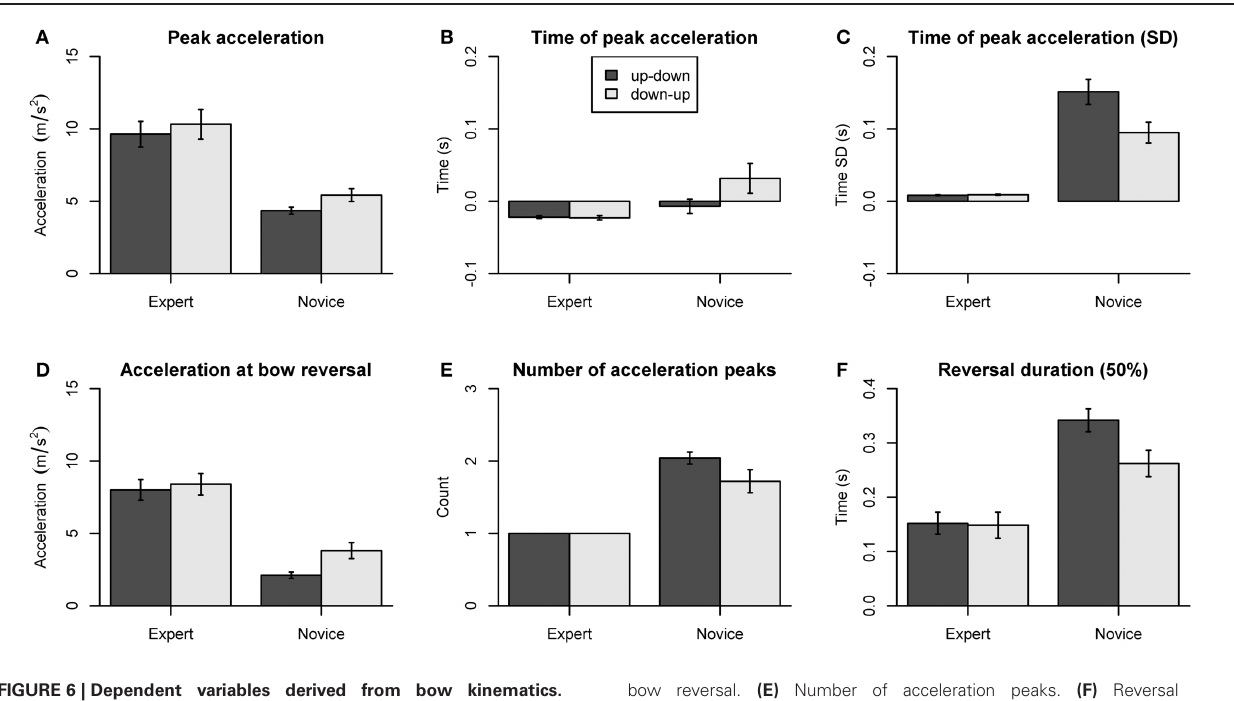
FIGURE 6 | Dependent variables derived from bow kinematics. (A) Peak acceleration. (B) Time of peak acceleration. (C) Variability of time of peak acceleration (SD). (D) Acceleration at